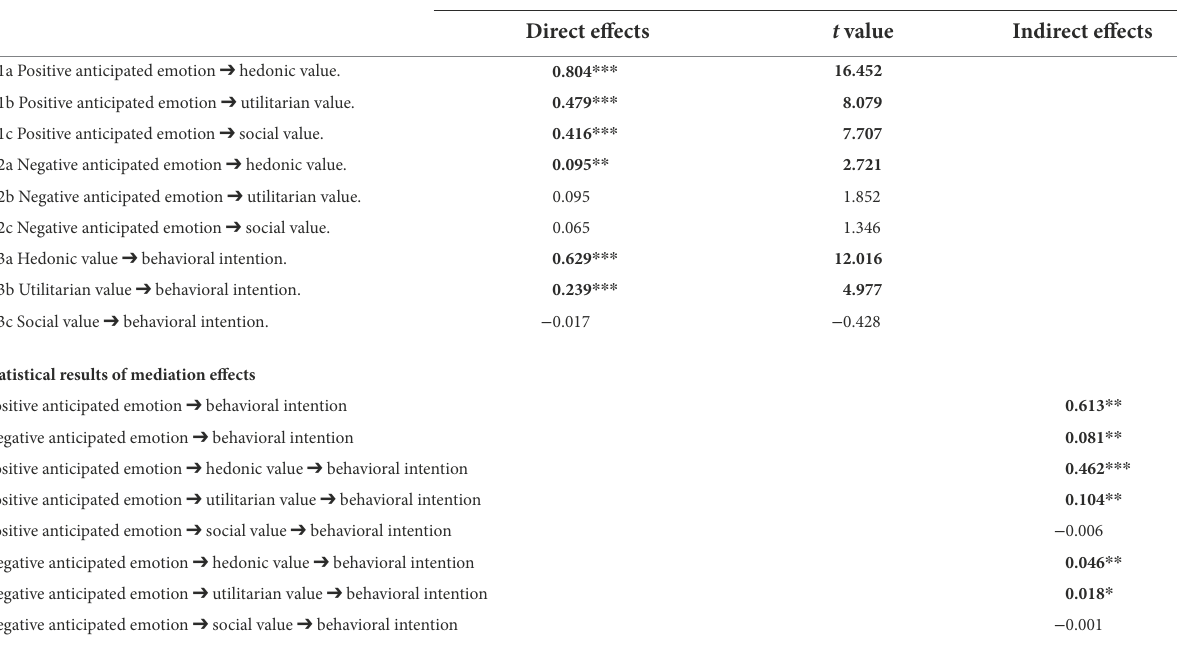
TABLE 4 Statistical results of direct, indirect, and mediation